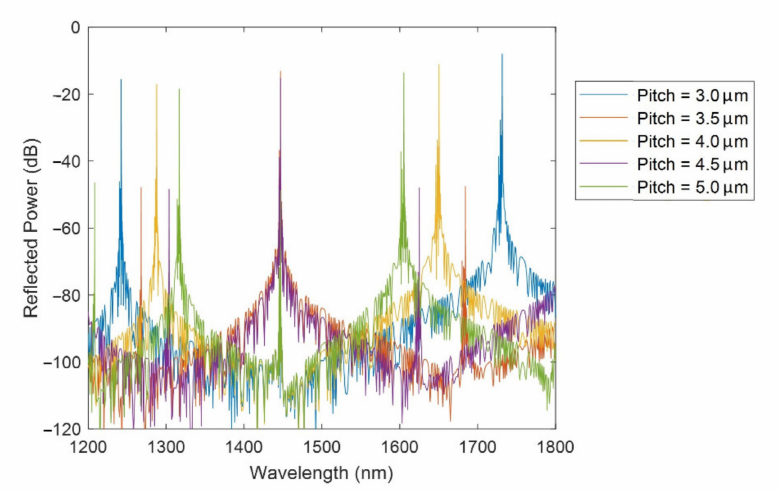
Figure 3. FBG bands in the 1200 - 1800 range for different